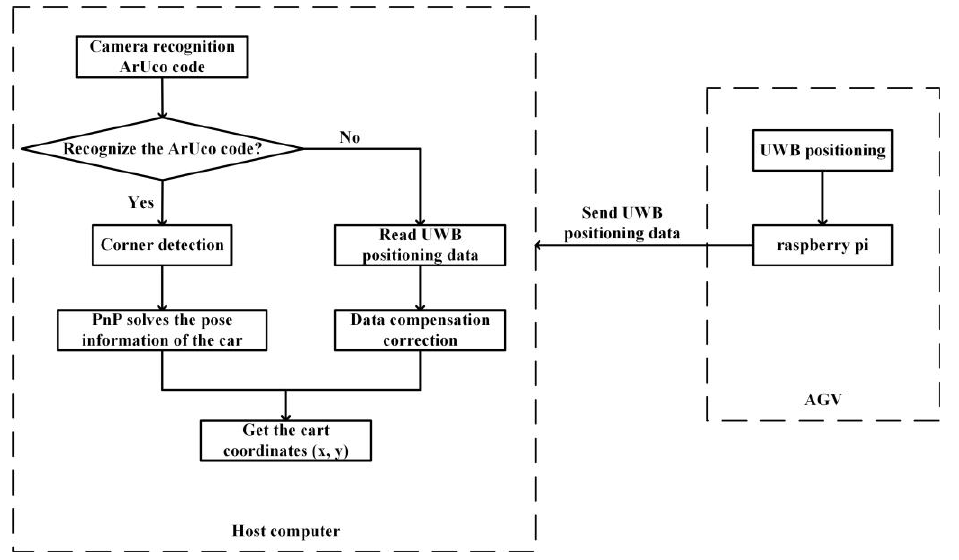
Figure 6. Flow chart of the localization method.